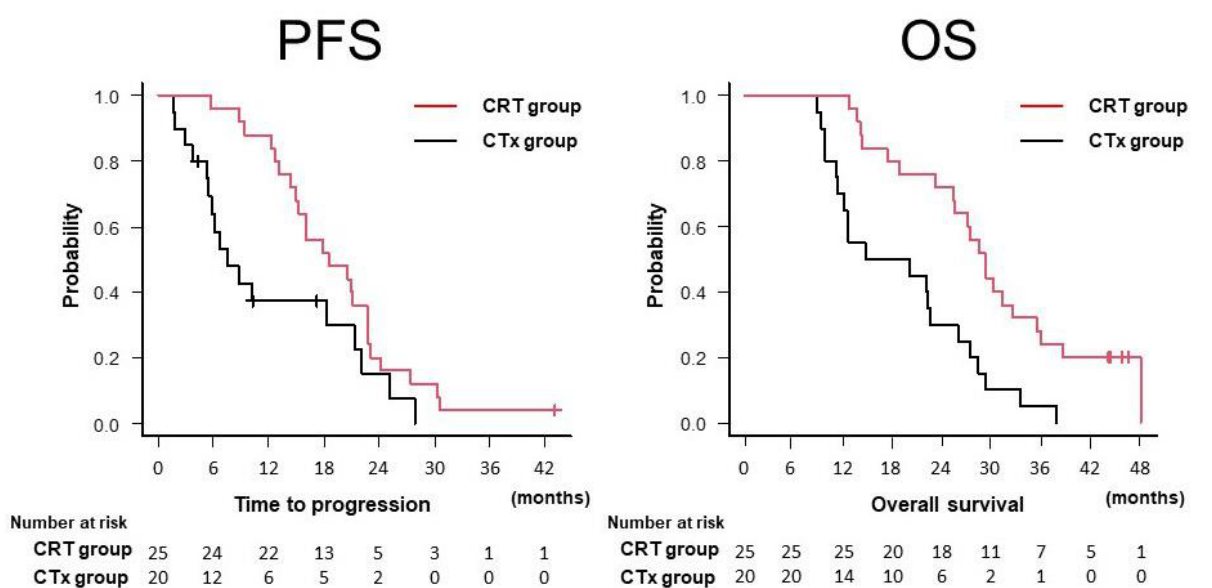
Cancers 2021 , 13 , 4733 Figure 2. Kaplan–Meier curves for PFS and OS in the CRT and CTx groups. OS, overall survival; PFS, progression-free sur-